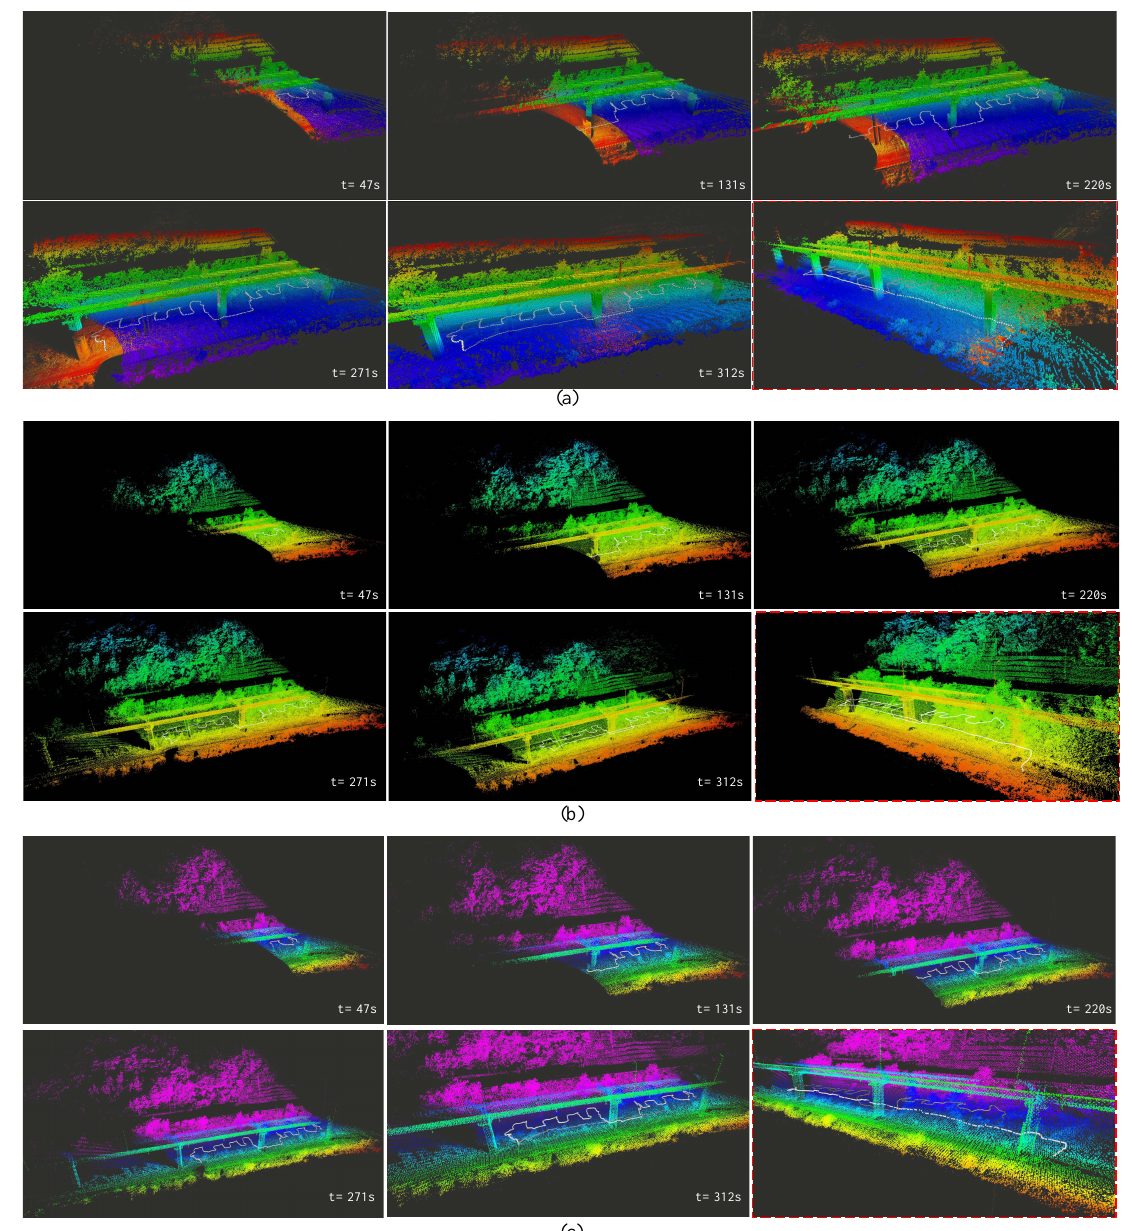
Figure 10. Experimental results obtained using different methods at Deungseon Bridge for a complicated zigzag path: our method vs. LOAM vs. LIO-mapping. ( a ) Results of the proposed method: The white line represents the estimated trajectory of the UAV. The lower right image is the final map. ( b ) Results of LOAM: The white line represents the estimated trajectory of the UAV. The lower right image is the final map. ( c ) Results of LIO-mapping: The white line represents the estimated trajectory of the UAV. The lower right image is the final